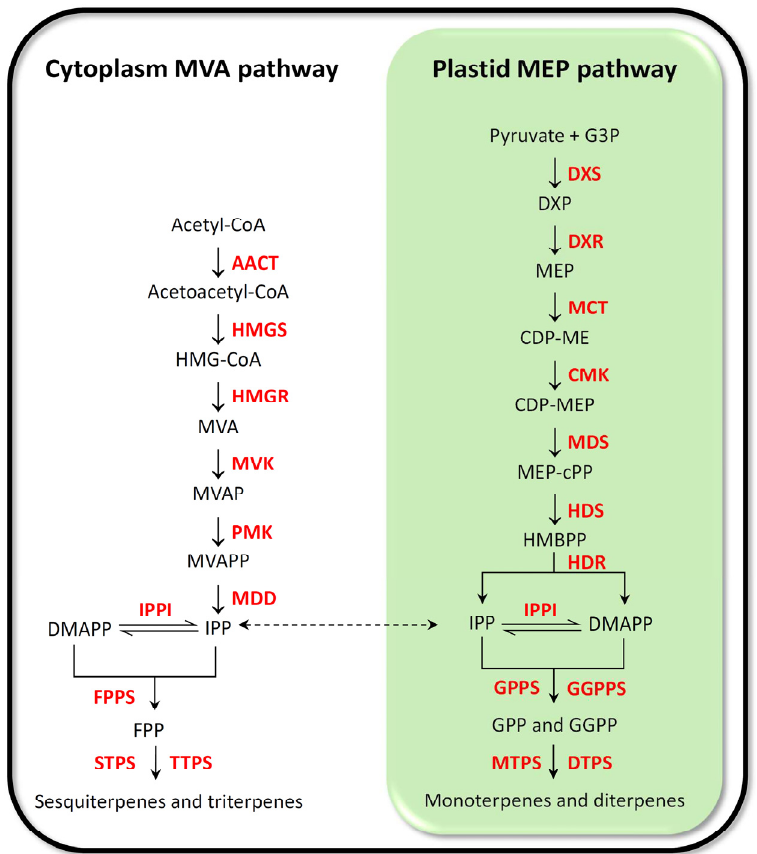
Figure 5. Biosynthesis of IPP and DMAPP through MVA and MEP pathway in plants. Although IPP and DMAPP act as precursors for all terpenes, sesqui-, and triterpenes biosynthesis typically is fed by the cytosolic MEV pathway, while mono-, di-, and tetraterpenes biosynthesis typically is fed by the plastidial MEP pathway. AACT: acetoacetyl-CoA thiolase (EC 2.3.1.9); CMK: